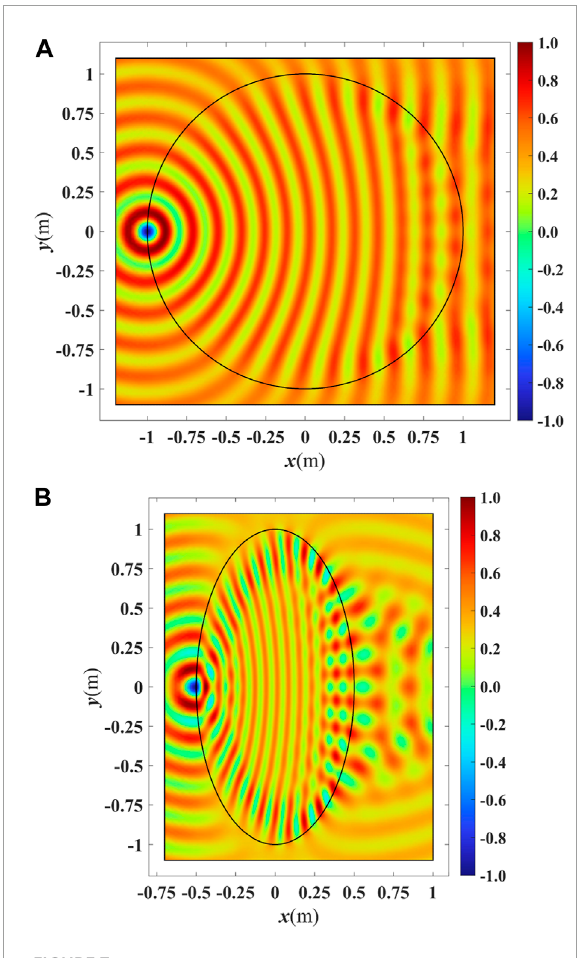
FIGURE 7 Simulation results for (A) an uncompressed Luneburg lens and (B) a compressed Luneburg lens with a semi-minor axis of δ = 0 . 5. A point source on the lens rim feeds the lenses with a TE polarized